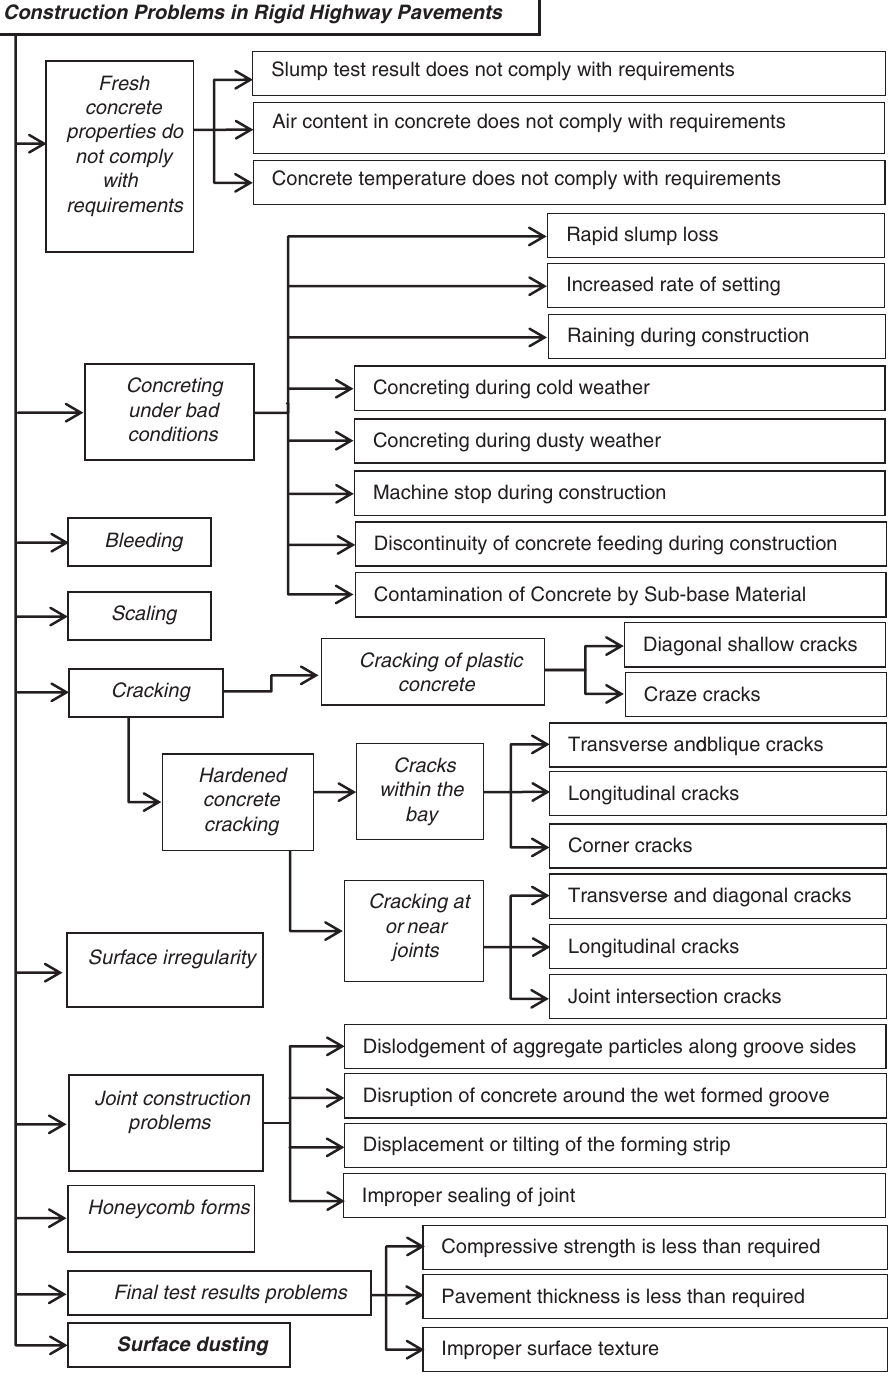
Fig. 1. Construction problems in rigid